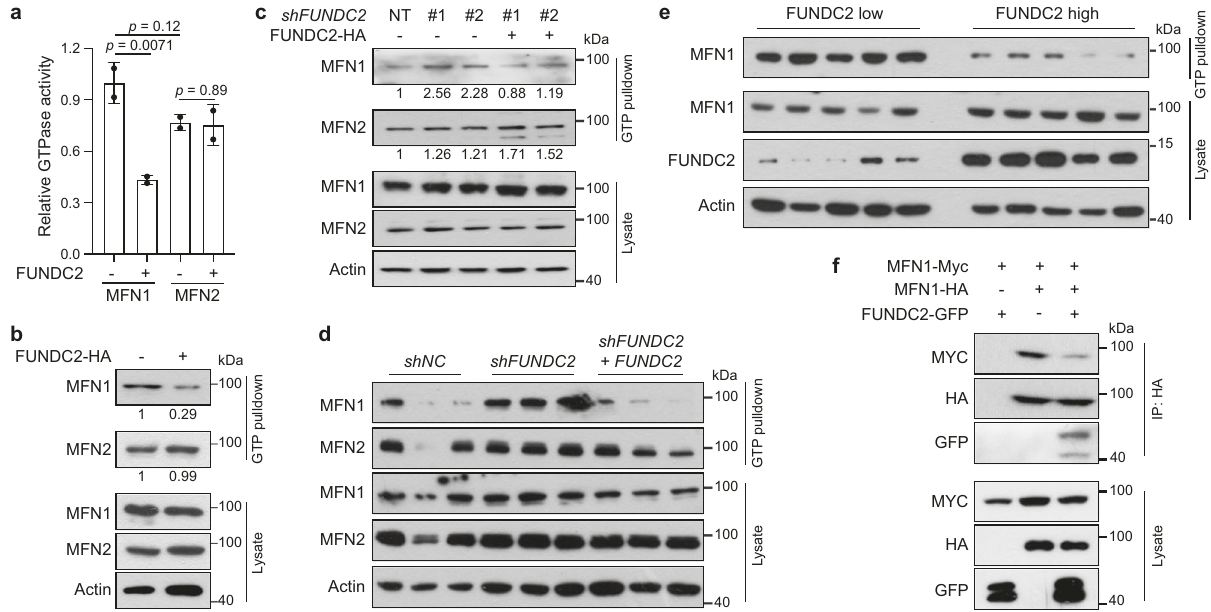
Fig. 5 FUNDC2 inhibits GTPase activity of MFN1. a FUNDC2 inhibits GTPase activity of MFN1 but not MFN2. MFN1/2 were expressed and immunoprecipitated from ΗΕΚ 293 Τ cells, and subjected to in vitro GTPase assay, n = 2 biological replicates. b , c FUNDC2 inhibits GTP loading of MFN1. FUNDC2 was overexpressed ( b ) or knocked down ( c ) in Huh-7 cells. Cell lysates were subjected to pulldown by GTP-agarose, and samples were then examined by western blotting. Quanti fi cation was done using Image J. d Knockdown of FUNDC2 increases GTP binding of MFN1 in MYC + RAS tumors. Experiments were similar to ( b ) except that indicated tumor samples in triplicates were used. e MFN1 in human HCC with higher FUNDC2 levels exhibits lower binding to GTP. FUNDC2 high and low tumor samples were lysed and subjected to GTP-agarose pulldown assay. f FUNDC2 inhibits trans association of MFN1. ΗΕΚ 293 Τ cells were transfected and immunoprecipitated as indicated. Data are presented as mean ± SD. p values were calculated by two-tailed unpaired Student ’ s t -test. Experiments in b – e were repeated twice, and f was repeated three times. Source data are provided as a Source data fi